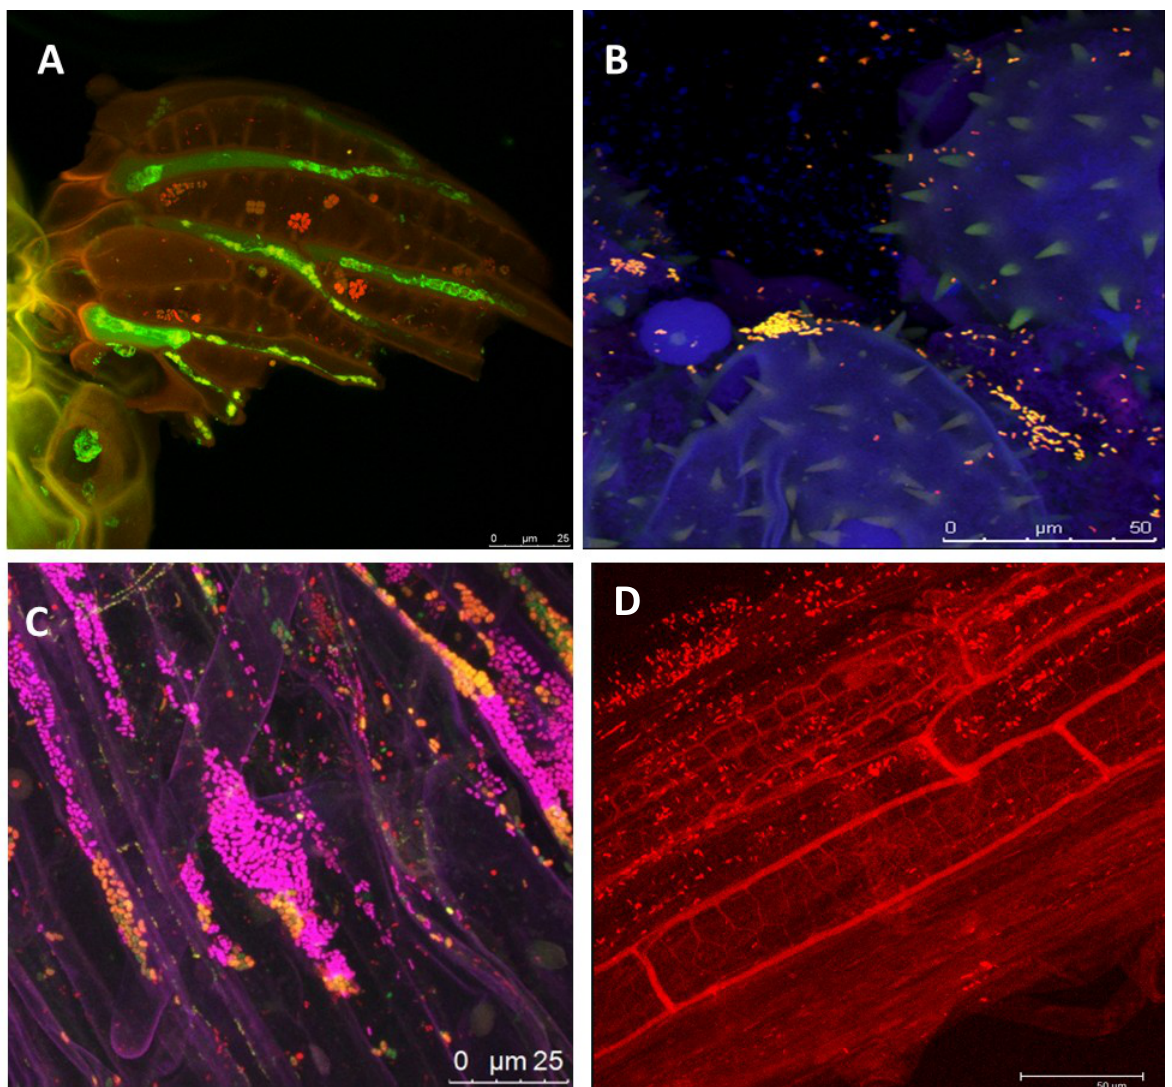
Figure 1. The plant as natural meta-organism visualized by Fluorescence in situ hybridization ( A – C ) and confocal laser scanning microscopy: ( A ) phyllosphere of a Sphagnum leave showing Alphaproteobacteria (yellow) and other bacterial colonies (red), ( B ) Gammaproteobacteria (yellow) and not taxonomically classified bacteria (red) on pumpkin pollen, ( C ) bacteria in the rhizosphere of lettuce showing Gammaproteobacteria (yellow) and Betaproteobacteria (pink), and ( D ) root of an oilseed rape root inoculated by the DsRed-labeled biocontrol agent Pseudomonas trivialis